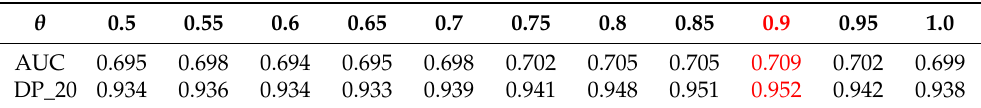
Table 5. AUC score and the DP_20 value of different contribution values of the modality with higher reliability. The best results are labeled in the red font.